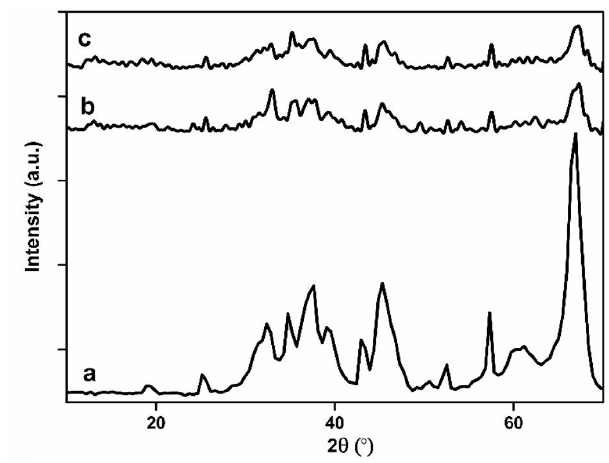
Fig. 2. XRD patterns of (a) alumina, (b) Zn